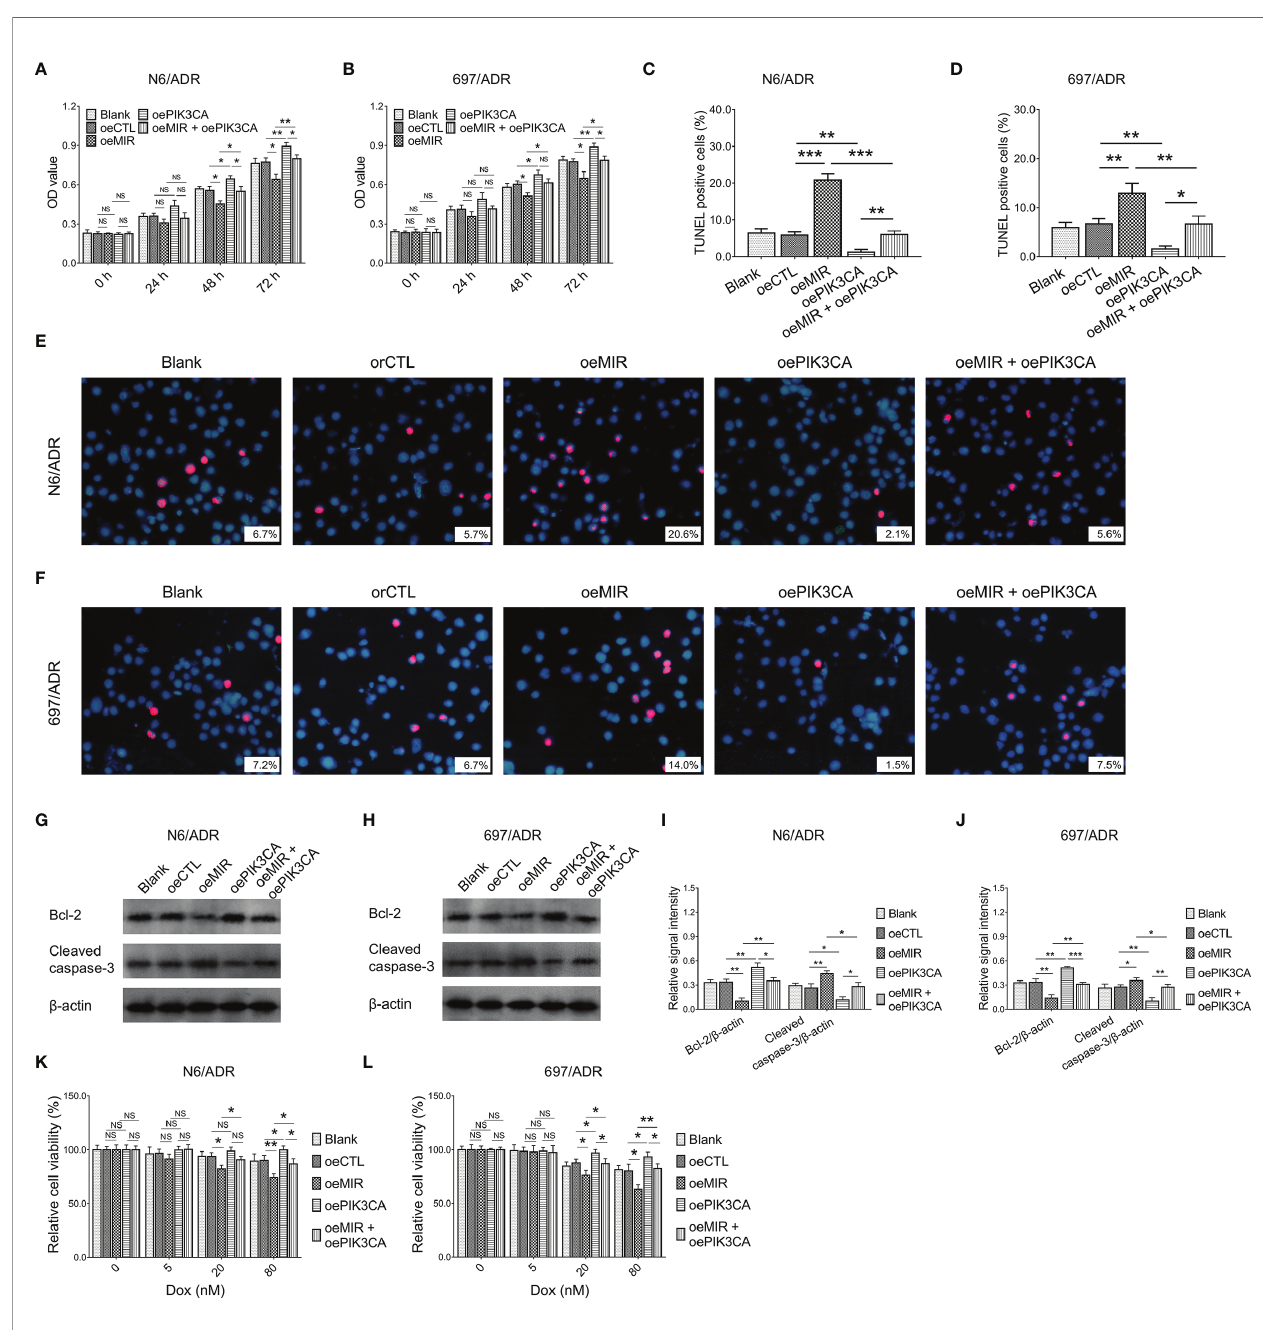
FIGURE 8 | Cell behaviors after miR-29a and PIK3CA modi fi cation. Cell proliferation by CCK-8 (A, B) , cell apoptosis rate (C – F) , apoptotic marker expressions (G – J) , and chemosensitivity to Dox (K, L) among blank, oeCTL, oeMIR, oePIK3CA, and oeMIR + oePIK3CA groups in N6/ADR cells and 697/ADR